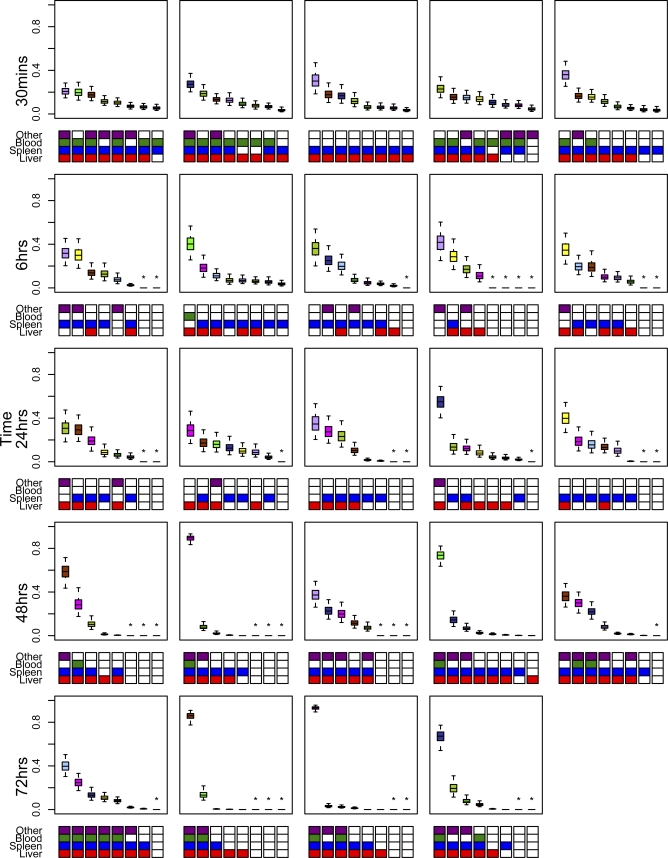
Proportions of WITS Distributions in MiceResults for the predicted proportions of each WITS within individual mice from one experiment, at 0.5, 6, 24, and 48 h p.i. (n = 5) and 72 h p.i. (n = 4). These were generated from an initial Bayesian linear regression model fitted to log10(conc.) against CT value (the point at which the fluorescence crosses the threshold) from the qPCR analysis. Each panel represents a different mouse, with boxes giving the median and quartiles, and the whiskers representing 95% credible intervals centred around the median. Within any panel, the left-hand box plot represents the most frequent WITS, and right-hand box plot the least frequent WITS. Below each panel, the four-line grid indicates the presence (shaded) or absence (white) of each individual WITS (as ordered in the panel directly above) in the different organs: “other organs” (purple), blood (green), spleen (blue), and liver (red). The individual WITS are indicated by coloured boxes (see Figure 3 for a detailed description). Asterisks indicate absence of WITS.